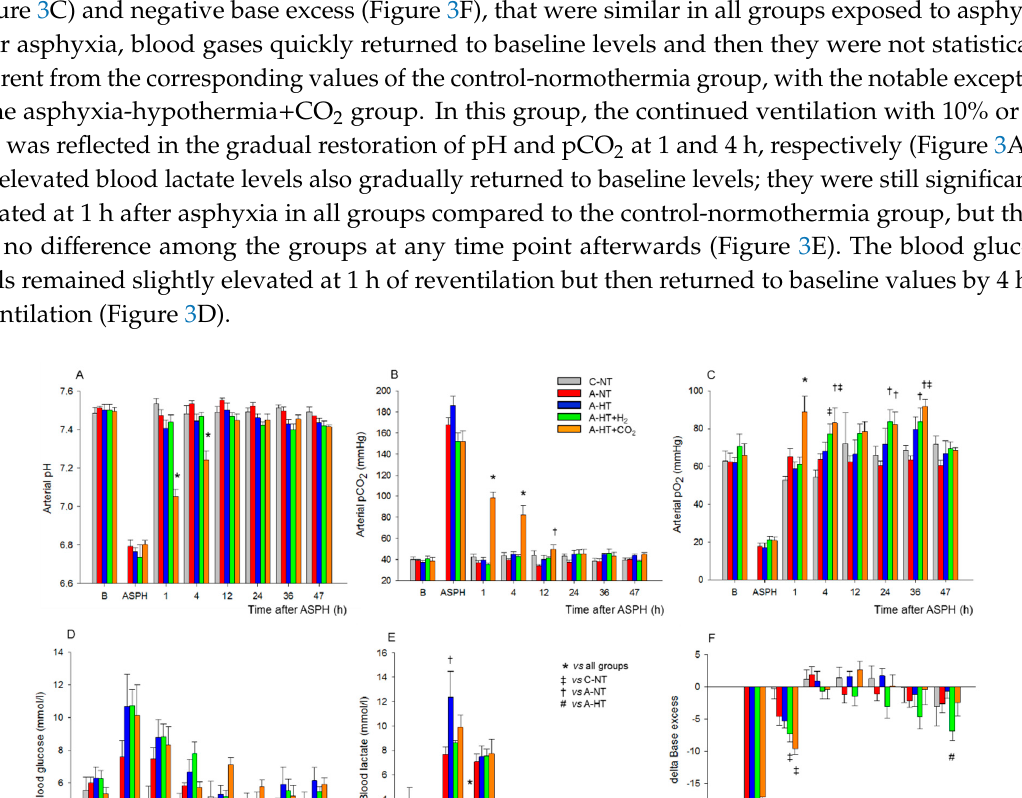
Figure 4. Cerebrocortical H 2 concentration changes during 2.1% H 2 ventilation. H 2 gas was ventilated to the animals ( n = 8 trials from n = 3 piglets) until steady state H 2 levels were reached at 10–15 min after initiation of H 2 ventilation (grey lines—individual traces, bold black line—mean). 2.2. Electroencephalography (EEG) Analysis